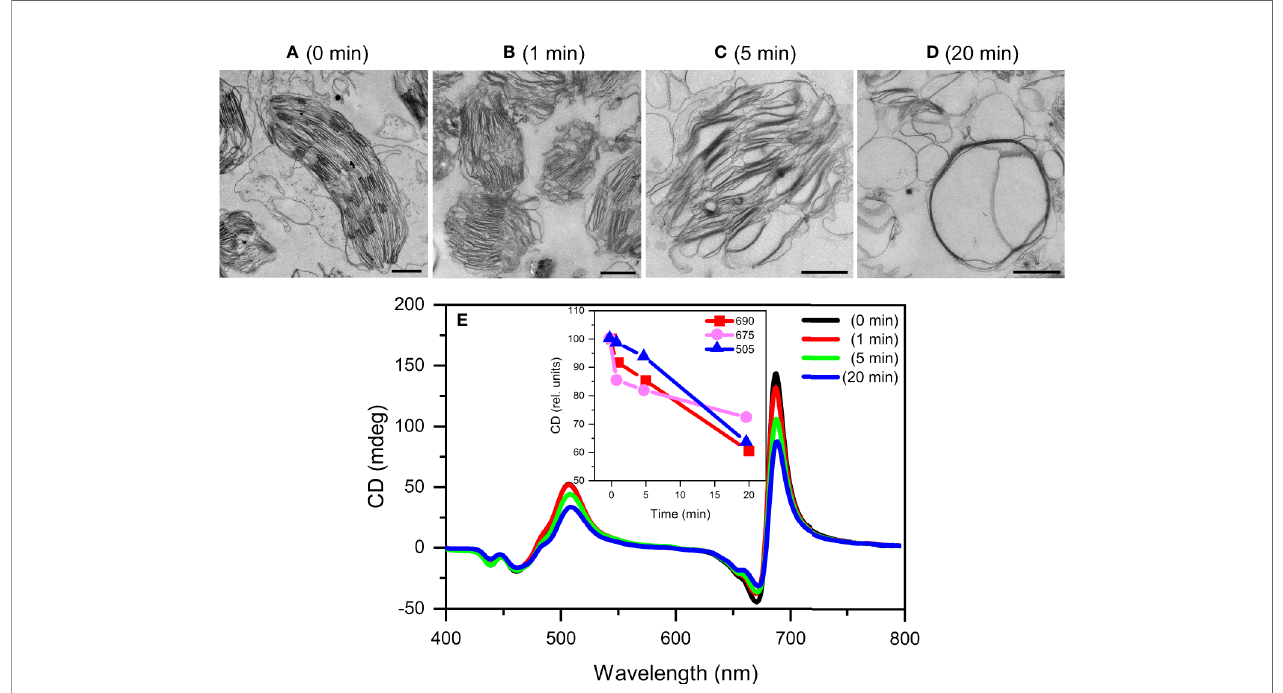
FIGURE 6 | Typical TEM images (A – ;D) and CD spectra (E) of untreated (0 min) and 0.5 M NaSCN treated isolated pea thylakoid membranes obtained after different time intervals following the treatment at t=0 min. The treatments were halted at 1, 5 and 20 min by 2% glutaraldehyde and the membranes were then used for TEM and CD experiments. Inset in (E) , time course of the variations in the different CD y bands. Scale bars in (A – D) , 1 m